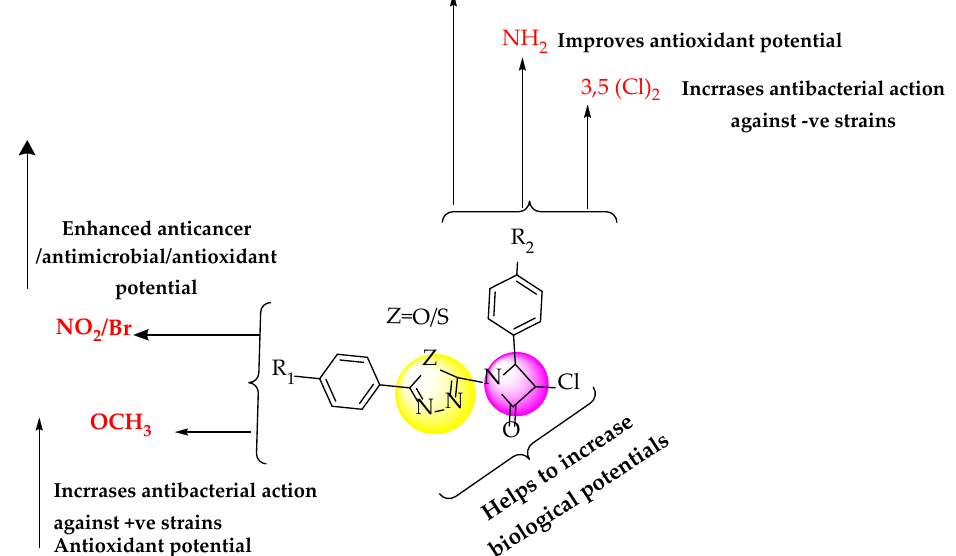
Figure 7. SAR studies of synthesized azetidin-2-one derivatives of 1,3,4-oxadiazole/thiadiazole ring .